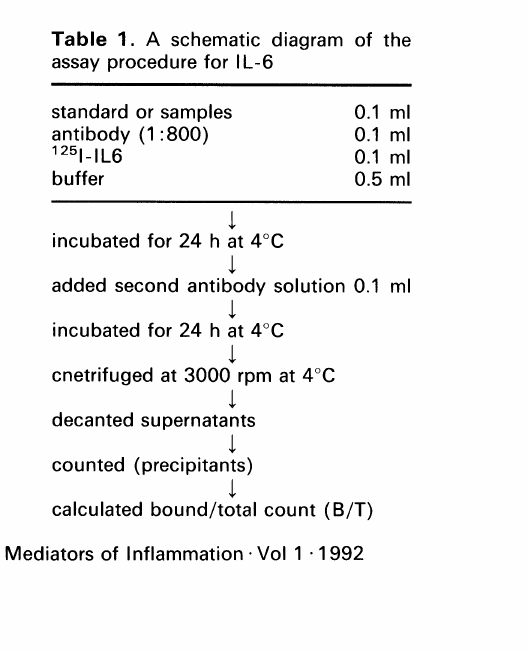
Table 1. A schematic diagram of the assay procedure for L-6 standard or samples